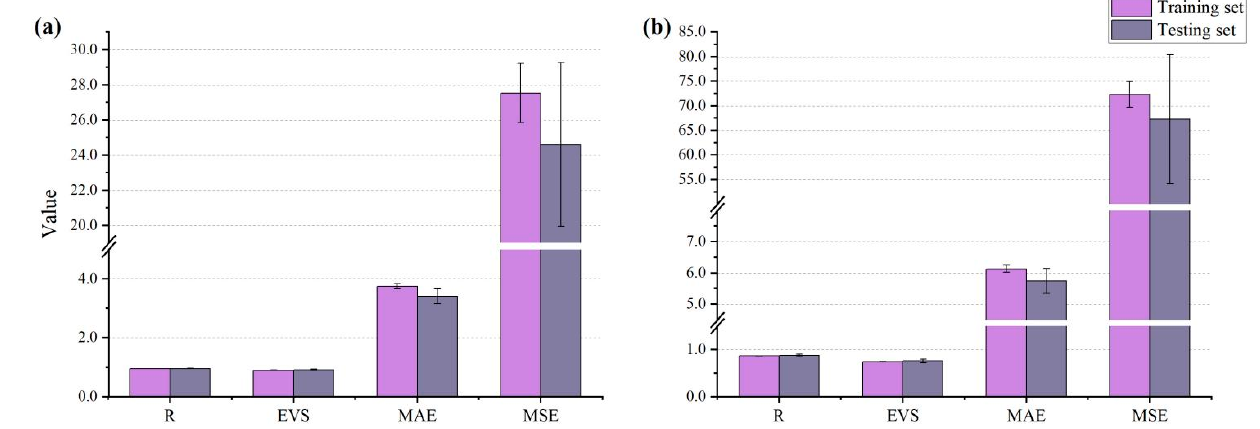
Figure 7. Performance measures for: ( a ) dataset 1 and ( b ) dataset 2.